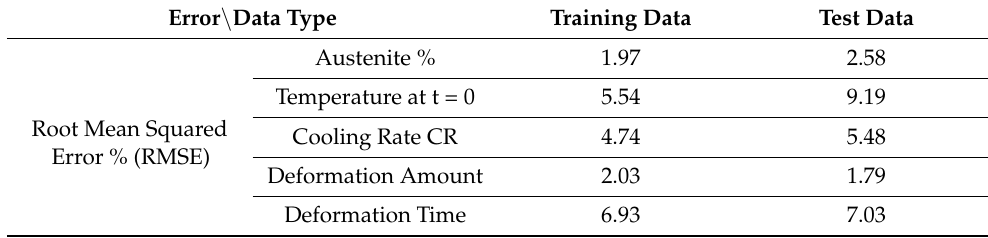
Table 9. Loss Functions for Step 3.1.